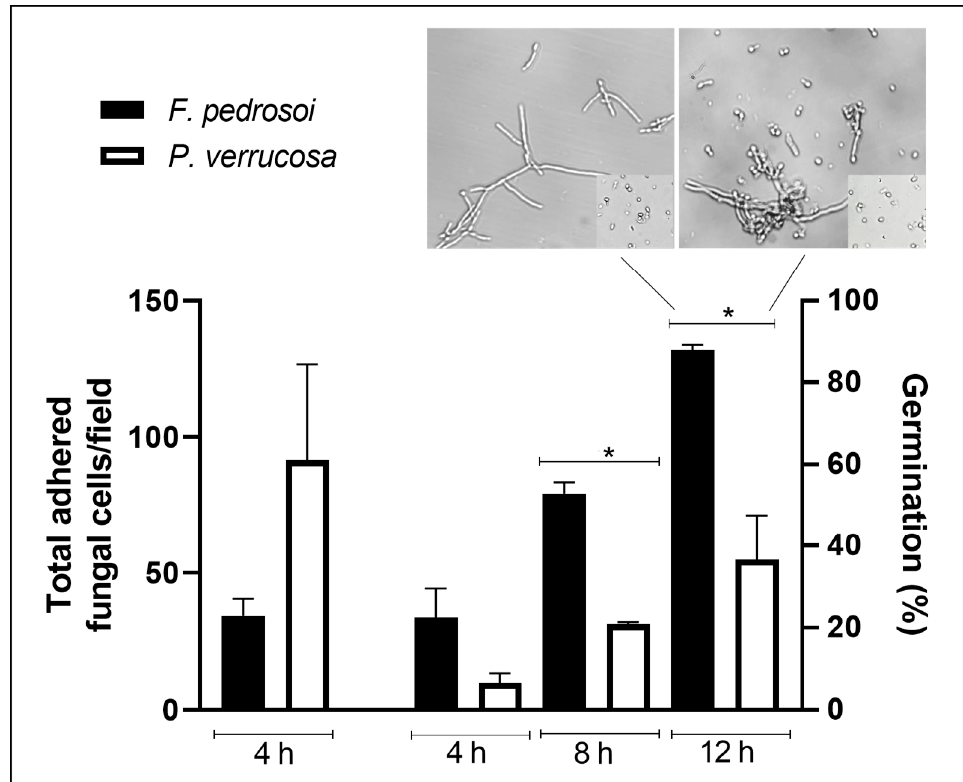
Figure 1. Fungal adhesion and germination on a polystyrene substrate. Fungal cells (1 × 10 6 ) were incubated at 37 ◦ C in a 24-well polystyrene plate containing RPMI medium. The wells were washed, and then the total adhered cell numbers per field after 4 h of incubation and the percentage of conidial germination at 4, 8 and 12 h were determined using the inverted microscope. Asterisks represent statistical significance ( p < 0.05). Images show fungal cells adhered to polystyrene after 12 h of germination. Inset: conidial cells before the adhesion process.